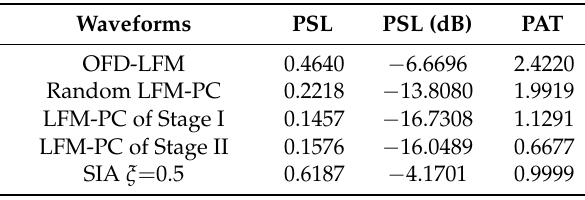
Table 4. Optimization results for one-main-lobe.